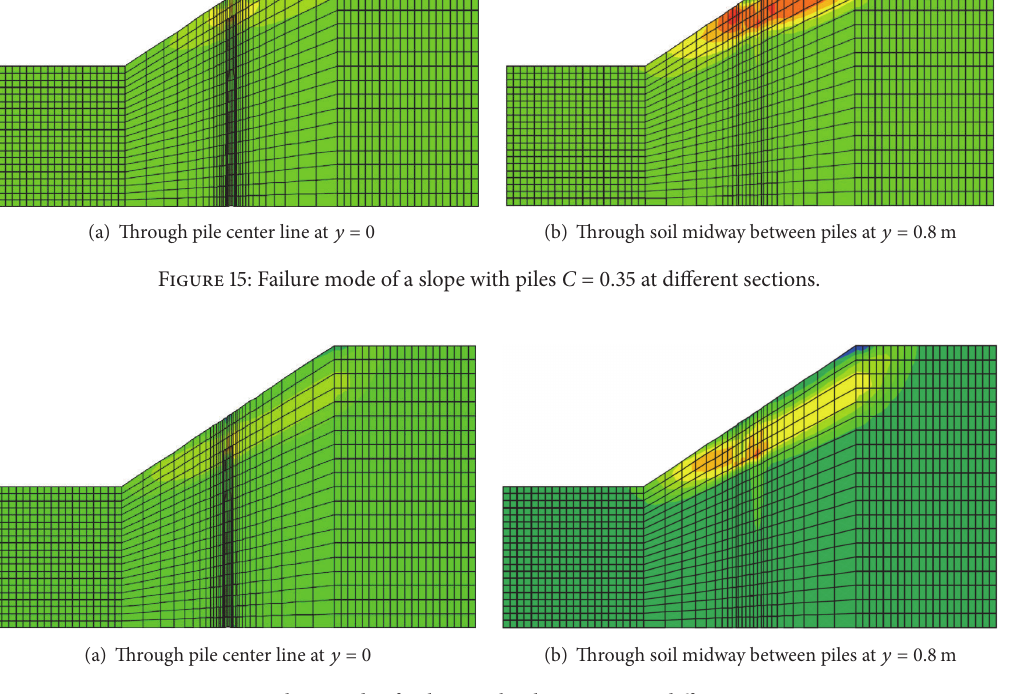
Figure 16: Failure mode of a slope with piles C = 0.53 at different